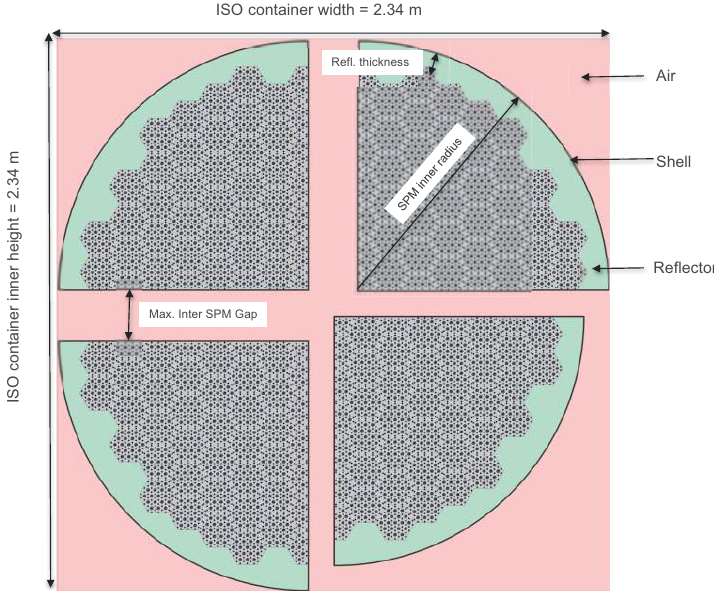
Figure 1. Transversal core layout with 3 out of 4 SPMs withdrawn for